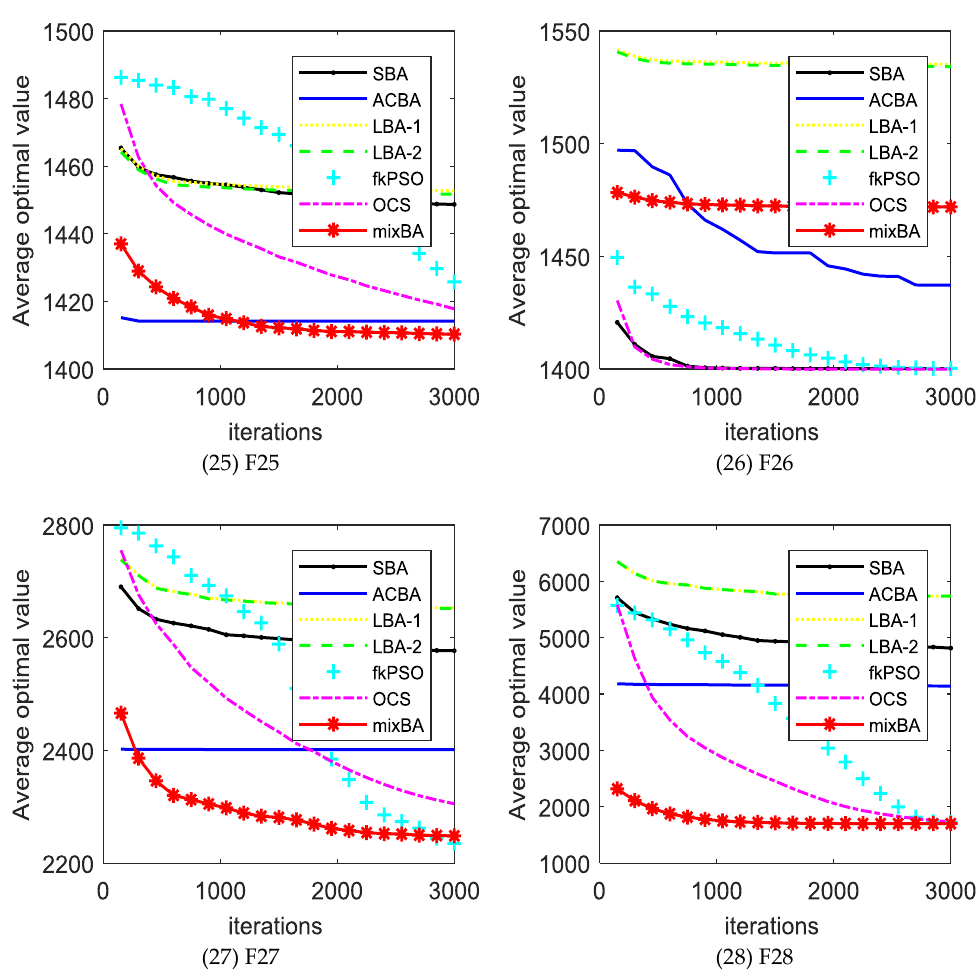
Figure 2. The convergence curves of different algorithms on the benchmark set. SBA—standard bat algorithm; ACBA—bat algorithm with arithmetic centroid strategy; LBA—bat algorithm with Lévy distribution; PSO—particle swarm optimization; OCS—oriented cuckoo search.